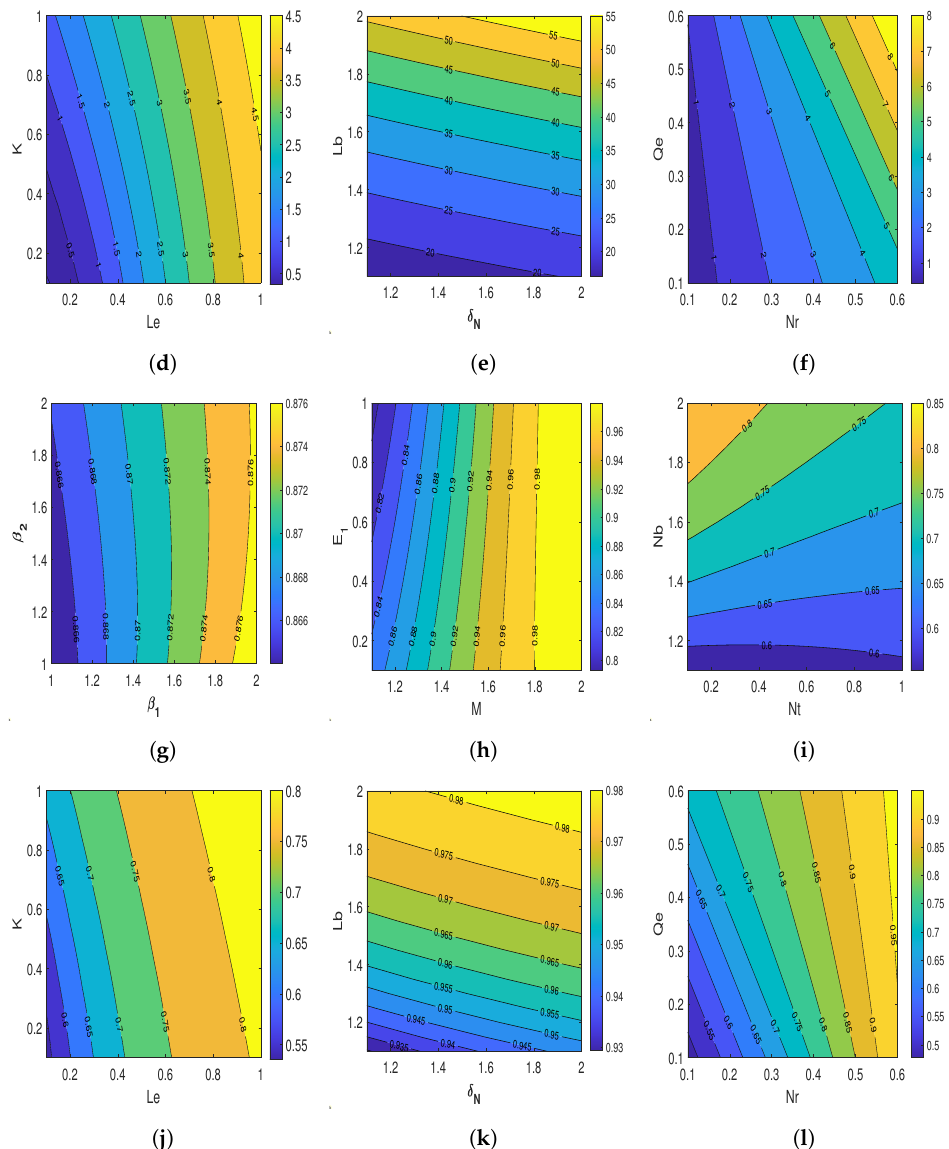
Figure 10. Contour plots illustrating the effect of various influential parameters on entropy generation and Bejan number. ( a ) Entropy via β 1 and β 2 ; ( b ) entropy via M and E 1 ; ( c ) entropy via Nt and Nb ; ( d ) entropy via K and Le ; ( e ) entropy via δ N and Lb ; ( f ) entropy via Nr and Qe ; ( g ) Bejan number via β 1 and β 2 ; ( h ) Bejan number via M and E 1 ; ( i ) Bejan number via Nt and Nb ; ( j ) Bejan number via K and Le ; ( k ) Bejan number via δ N and Lb ; and ( l ) Bejan number via Nr and Qe